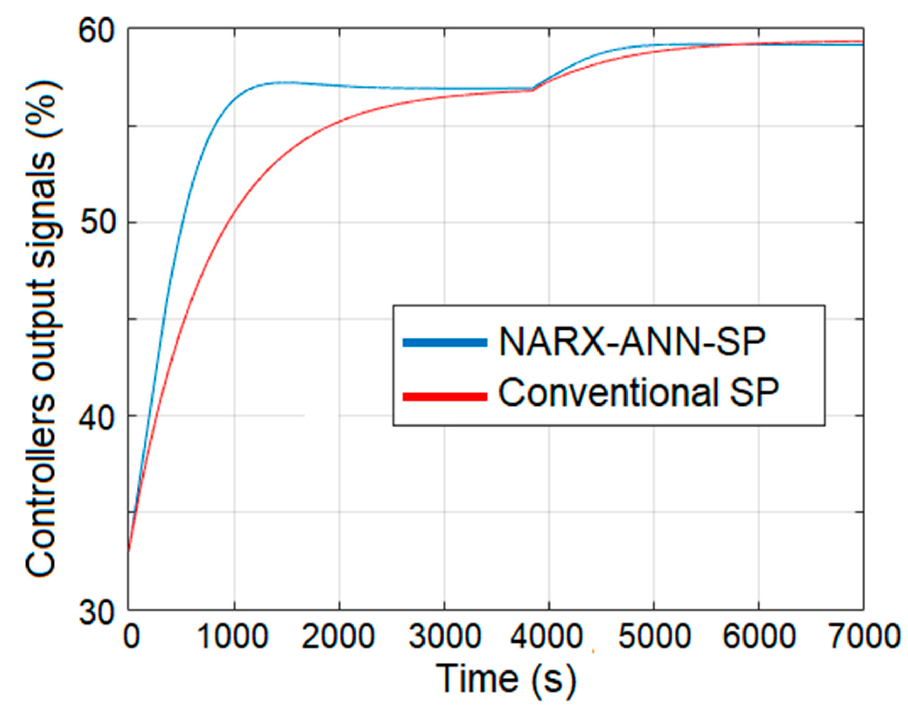
Figure 12. Experimental comparative output signals of the controllers designed.